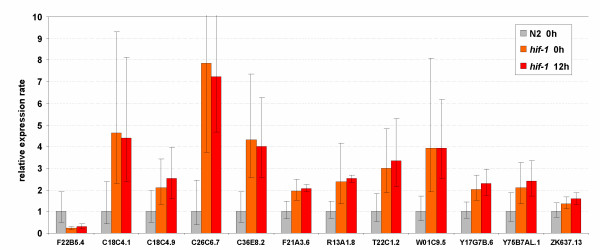
hif-1 mediates induction of the anoxia responsive genes. The expression ratio's are the average values from 3 replicate cultures (biological repeats). Bars indicate the 95% confidence interval of the mean. F22B5.4 is an established hypoxia responsive gene of unknown function [43] and is included as a positive control. Globin ZK637.13 is not sensitive to anoxia and was included as a negative control.